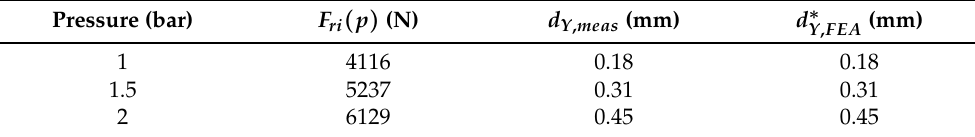
Table 9. Measured and calculated values of axial displacement at different pressure